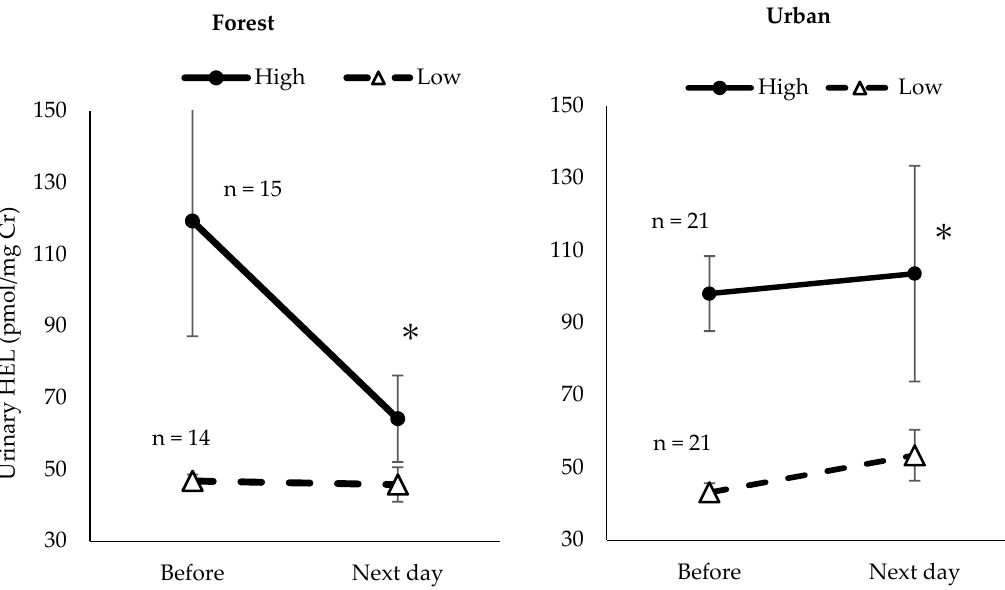
Figure 5. Alteration of urinary HEL concentrations in high or low HEL group after a forest walk or an urban walk. * p < 0.1: pre- vs. post-forest walk analyzed by Mann–Whitney U test. Data are expressed as mean ± SEM.